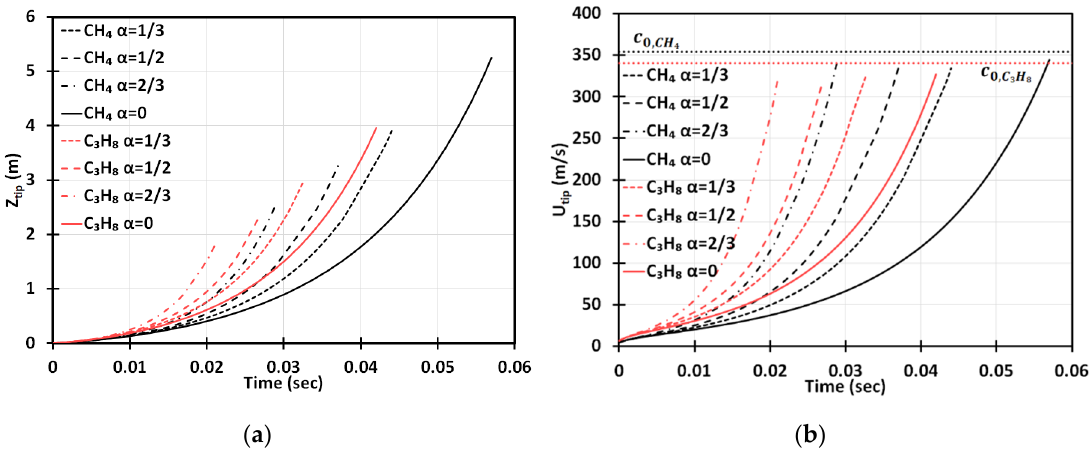
Figure 3. Time evolution of the flame tip position Z tip ( a ) and velocity U tip ( b ) in a cylindrical- axisymmetric geometry for stoichiometric CH 4 -air and C 3 H 8 -air burning with various blockage ratios, α = 0,1/3,1/2,2/3.